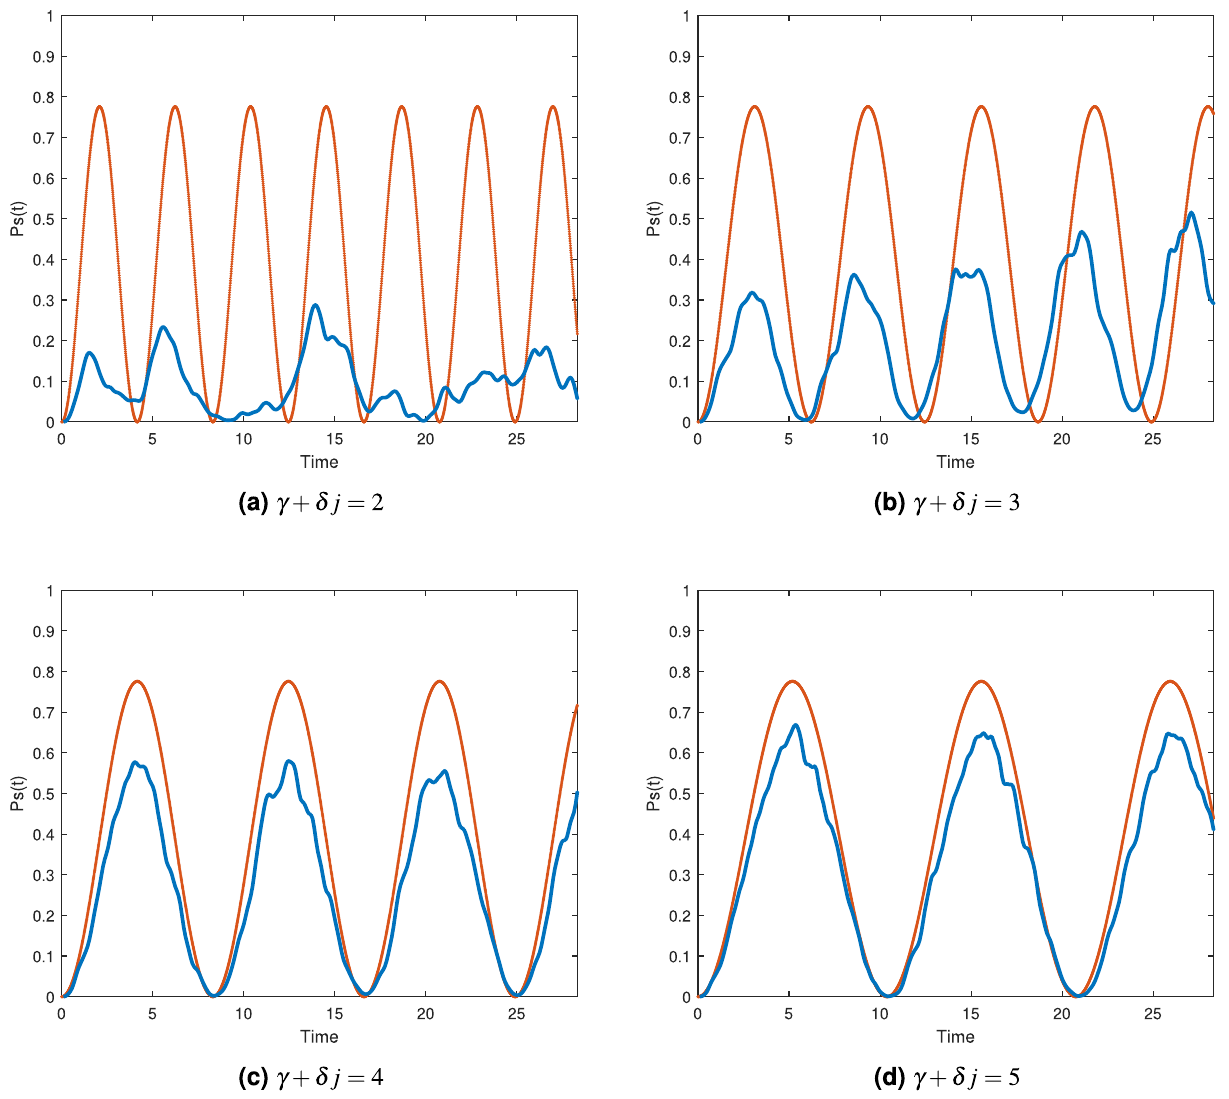
Figure 2. Comparison between simulations (blue line) and the analytical approximation (orange) of P s ( t ) for initial state | 110001 � , d H = 2